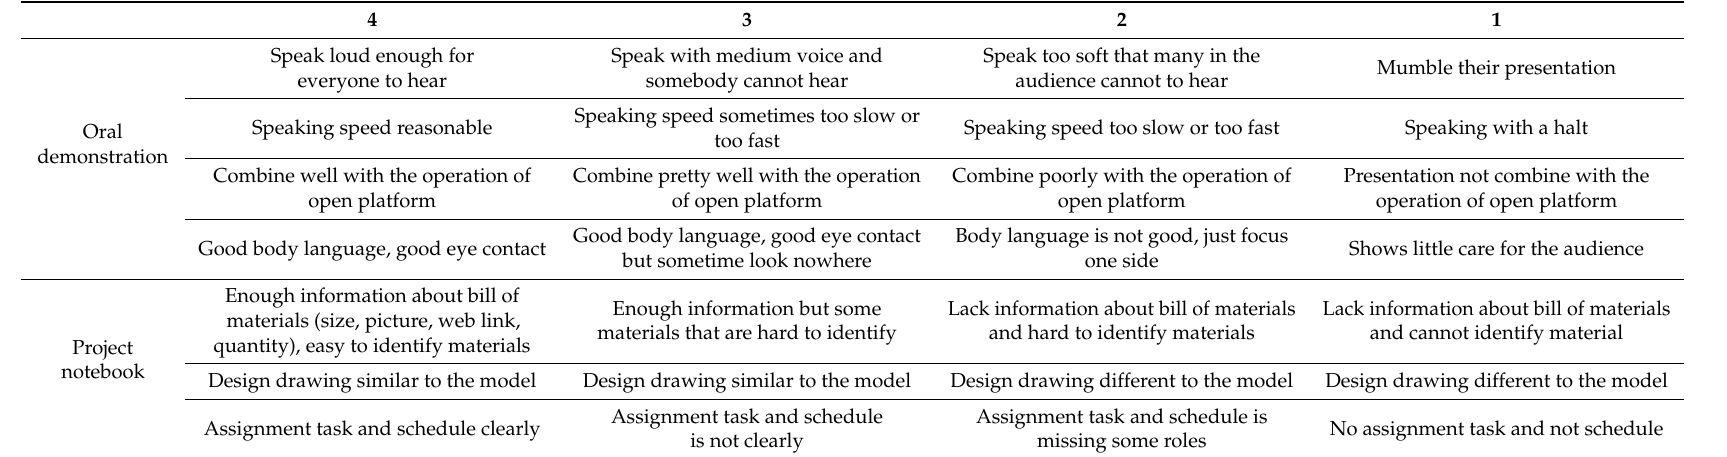
Table A2. Evaluations of Team Presentation.